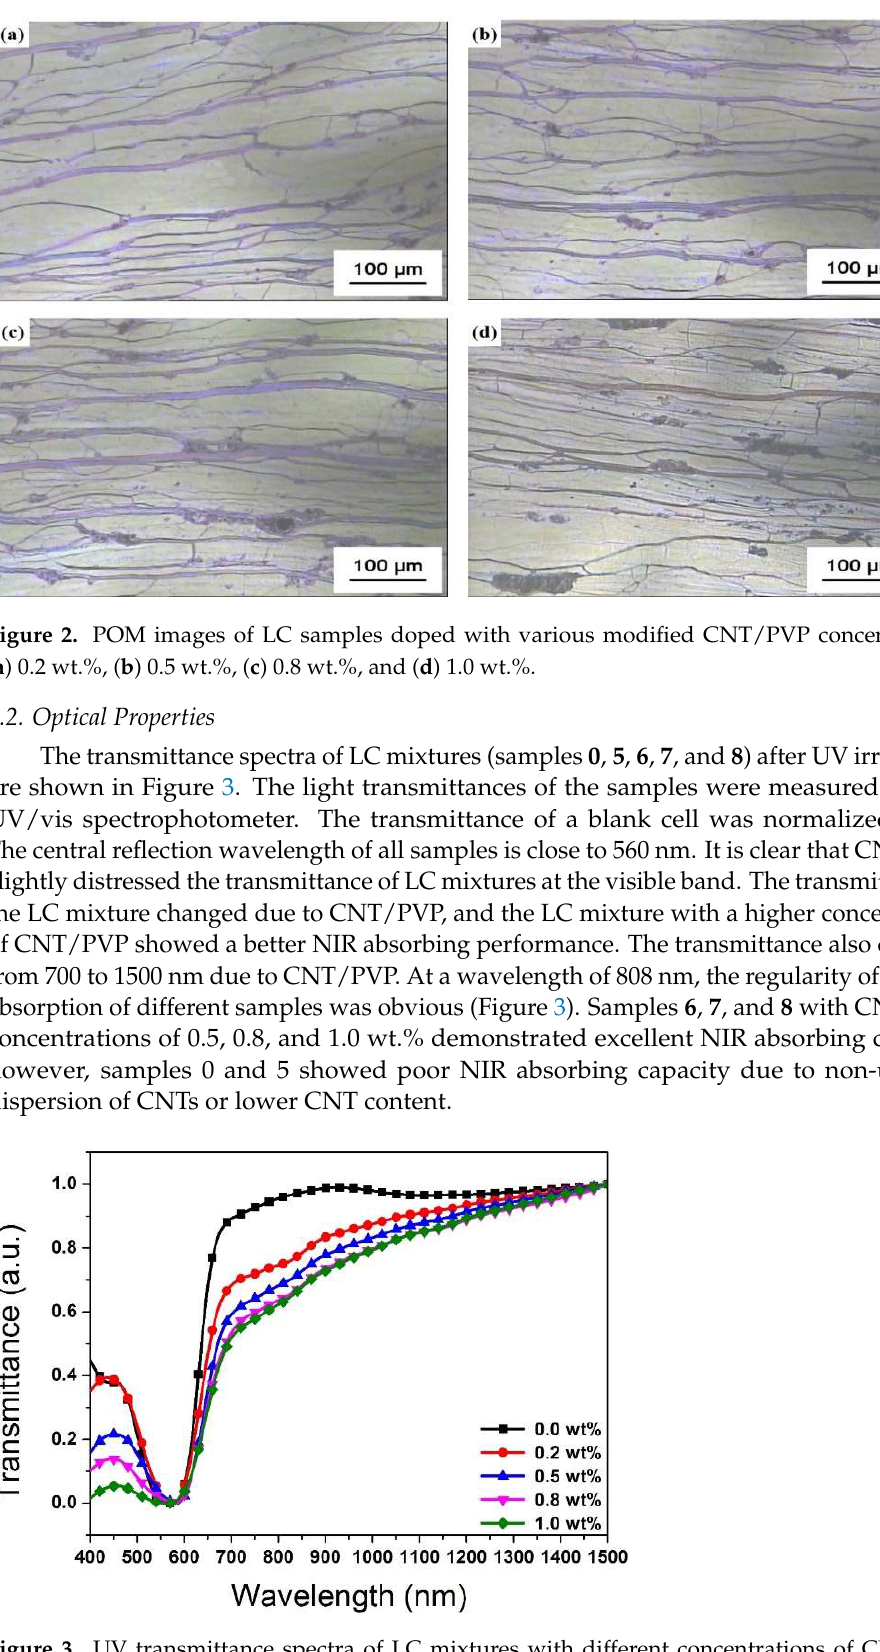
Figure 2. POM images of LC samples doped with various modified CNT/PVP concentrations: ( a ) 0.2 wt.%, ( b ) 0.5 wt.%, ( c ) 0.8 wt.%, and ( d ) 1.0 wt.%.